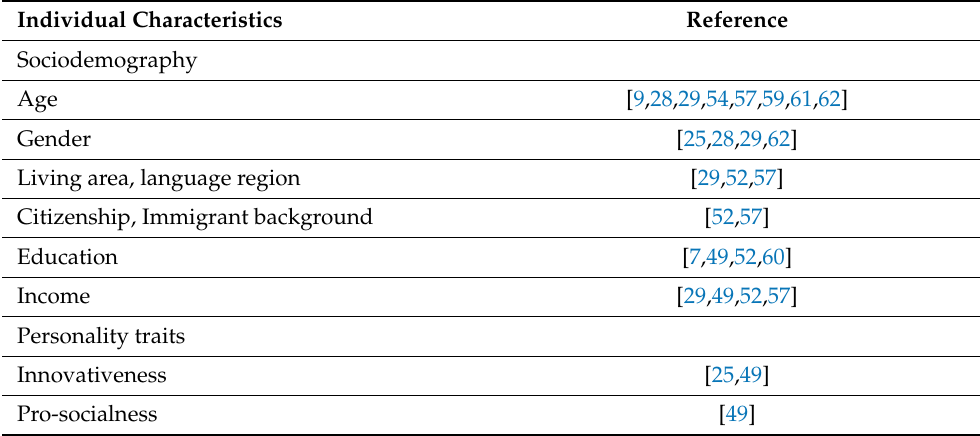
Table 2. Individual